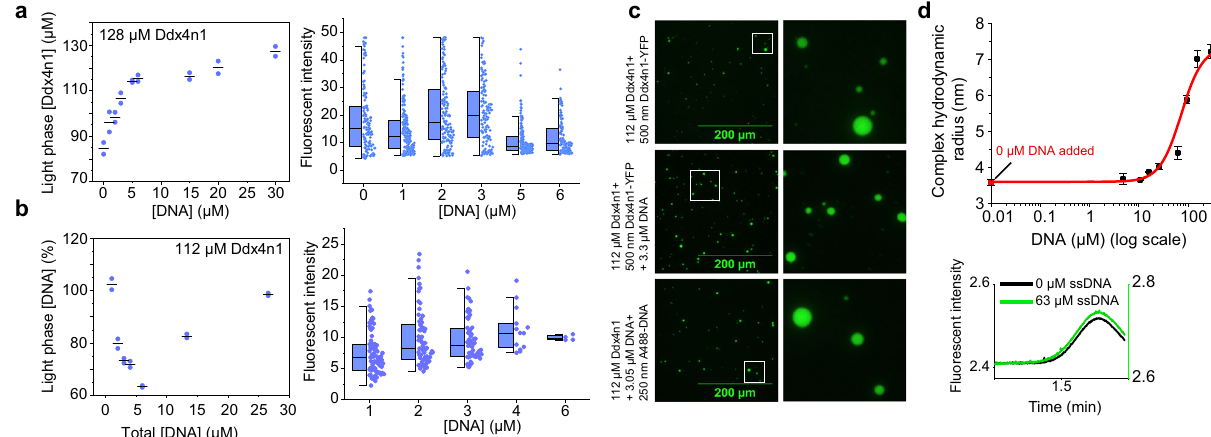
Fig. 2 In fl uence of ssDNA-Ddx4n1 biding on LLPS. a (Left panel) Dilute phase concentration of a 128 µ M Ddx4n1 (spiked with Ddx4n1-YFP) as a function of added unlabeled ssDNA is plotted. The data represents replicate values and mean (black line) from n = 2 independent experiments. (Right panel) Peak intensity distribution of 128 µ M Ddx4n1 as a function of unlabeled ssDNA added. n = 2 independent experiments. b (Left panel) dilute phase ssDNA (spiked with 5% L-DNA) concentration as a function of total ssDNA added to 112 µ M unlabeled Ddx4n1 is plotted. The data represents replicate values and mean (black line) from n = 2 independent experiments. (Right panel) Peak intensity distribution of 112 µ M unlabeled Ddx4n1 as a function of total ssDNA added with 0.5% spike of L-DNA. n = 2 independent experiments. c Representative fl uorescence microscopy images of droplets formed by 112 µ M Ddx4n1 with either Ddx4n1-YFP or Alexa488-DNA added as the fl uorescent tracer. The insets are magni fi ed on the right panel for better clarity. n = 2 independent experiments. d (Upper panel) Af fi nity determination between Ddx4n1-YFP and ssDNA is shown with increasing ssDNA concentration. The point with 0 µ M DNA added is indicated in red. The values represent mean ± SD for n = 3 independent experiments. (Lower panel) Taylor grams with 0 (black) and 63 µ M (green) ssDNA is shown for Ddx4n1. Source data are provided as a Source Data fi